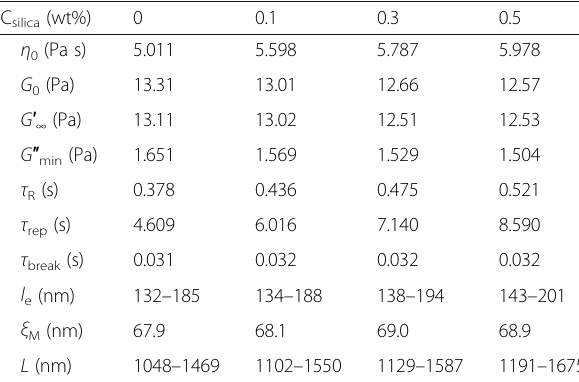
Table 2 The rheological parameters of wormlike micelles with different silica concentrations